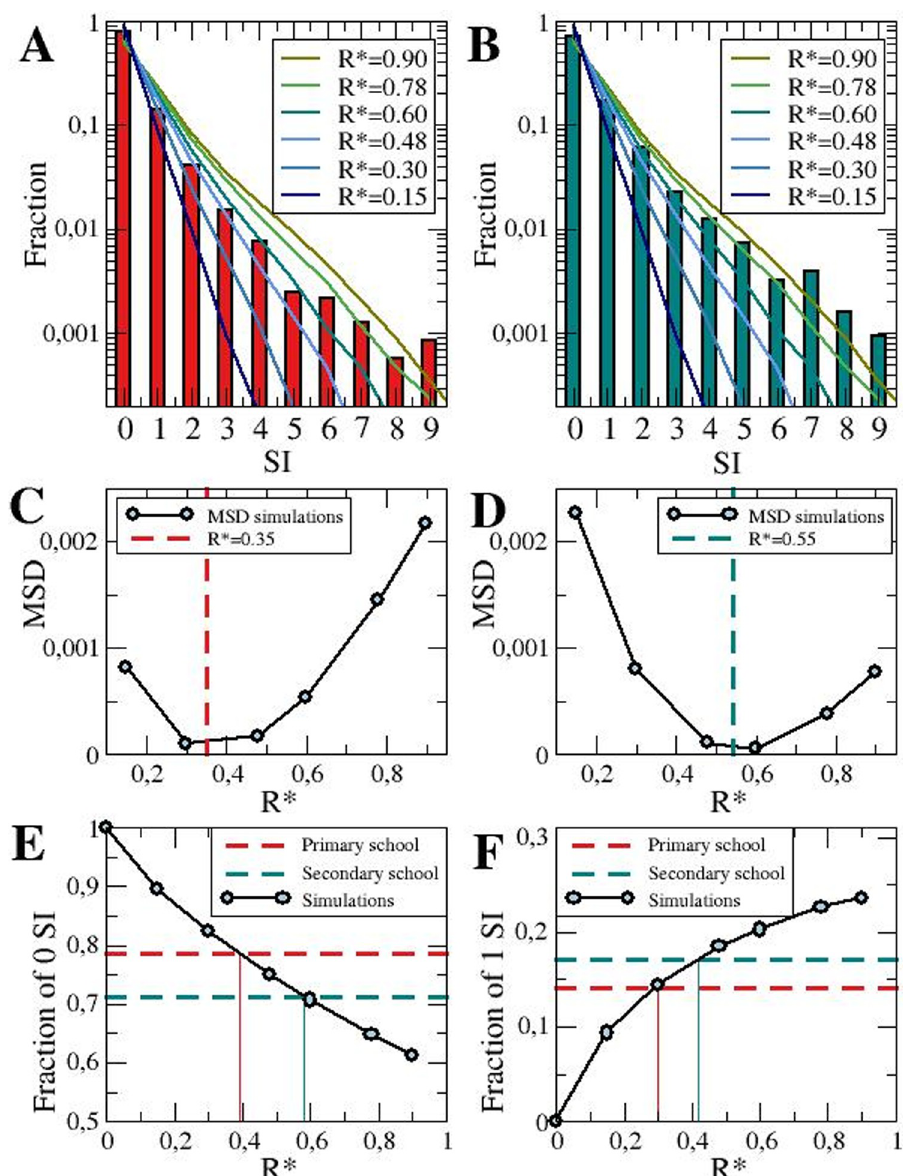
Fig 4. Estimation of the probability of contagion from epidemiological data. Fraction of groups going into quarantine with a number N of secondary infected (SI) students by COVID-19 for primary (A) and secondary (B) schools. Bars of the data are shown in comparison with the fraction of groups with a number N of cases of COVID-19 obtained from the numerical simulations (coloured lines) (A and B). Note that y-axis is plotted in a logarithmic scale. Mean square displacement (MSD) of the fractions obtained from the simulations with different values of R � with the data obtained from Primary (C) and Secondary (D) schools. Vertical dashed lines correspond to the reproductive number calculated from the data obtained from Primary and Secondary schools. Dependence of the fraction of a single case (E) and two cases (F) on the probability of contagion R � (solid line with circles) in comparison with the fraction obtained in the schools. Red and green dashed lines correspond, respectively, to the fraction in primary and secondary schools of single infected child (E) and two infected students (F). Simulations are done keeping A 14 = 250 cases per 10 5 inhabitants, and the total number of groups of 20 students fixed to 72000. Data from primary and secondary schools are shown in S1 Table, obtained from the Government of Catalonia.